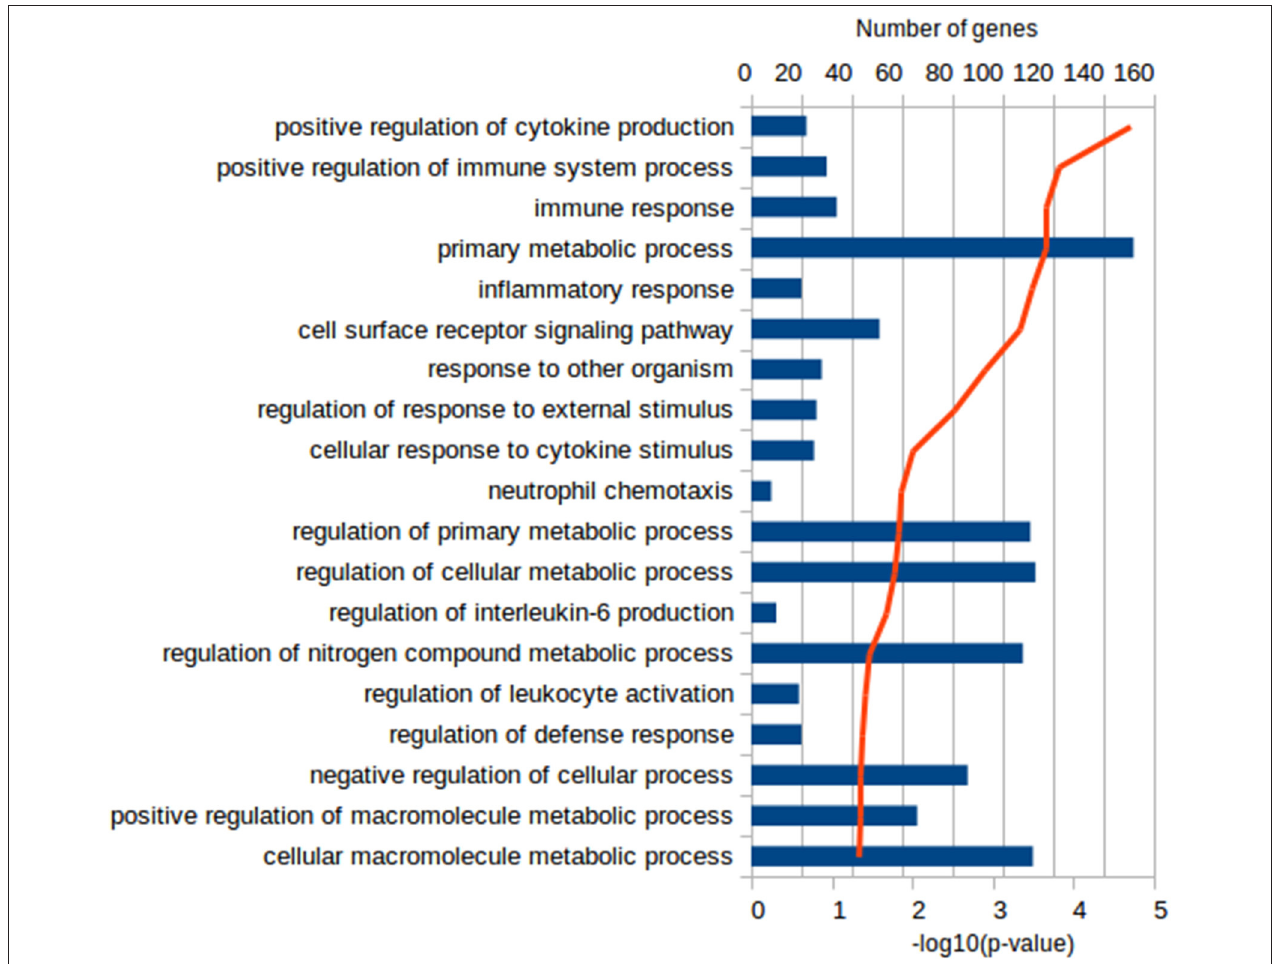
FIGURE 4 | The most enriched GO terms in the Biological Process ontology in the Adj Tf vs. Vac Tf comparison in PANTHER with the Fisher’s exact test and Benjamini-Hochberg False Discovery Rate correction. The blue bars depict the number of genes in the enriched terms, while the red line the adjusted- p